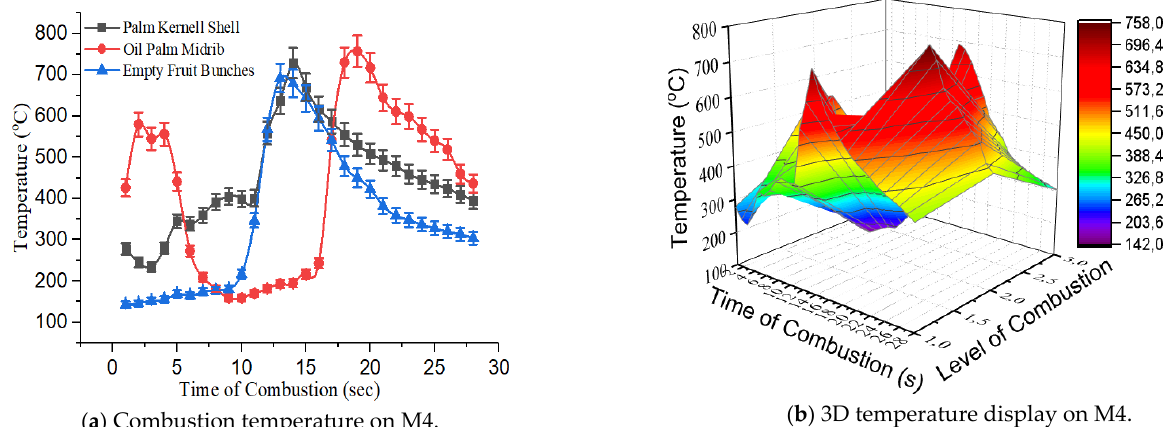
Figure 8. Temperature measurement at M4 with different fuels. The last analysis of the combustion chamber temperature on the outer wall aimed to calculate the level of combustion efficiency. The phenomenon and temperature of the outer combustion chamber walls are necessary to predict the level of efficiency produced. The outer wall temperature of the PKS combustion indicated a stable temperature compared